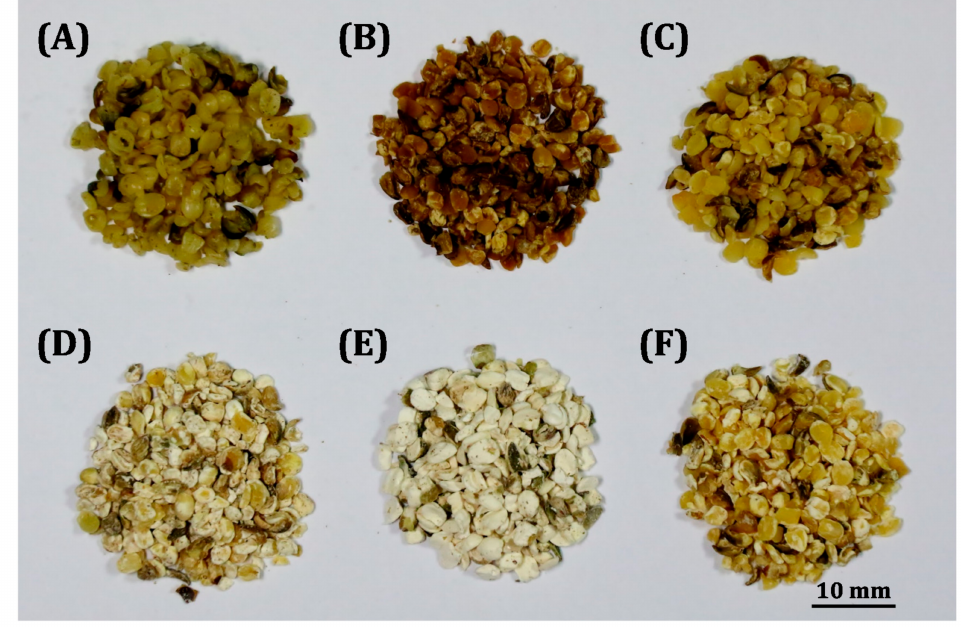
Figure 4. Images of ( A ) crude hemp nut and hemp nut after ( B ) MAE, ( C ) HRE, ( D ) SE, ( E ) SFE, and ( F )